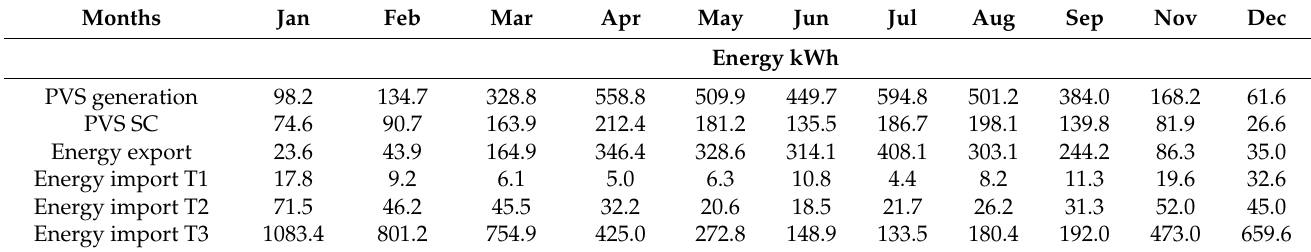
Figure 8. PV generation and the SC in 2020. Table 6. Monthly summary of imported, exported, produced PVS and